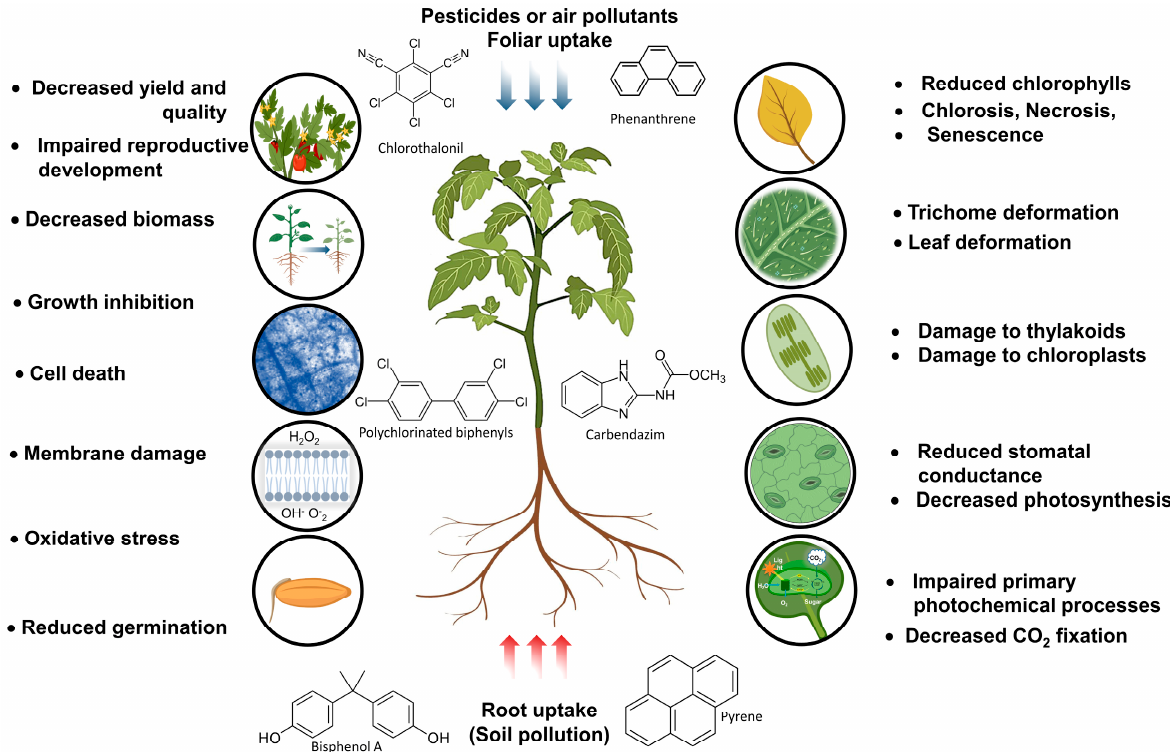
Figure 1. Deleterious effects of organic pollutants on plants and associated phytotoxicity.